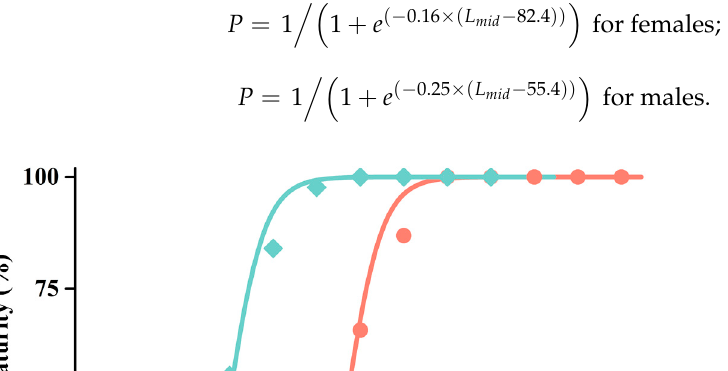
Figure 3. Relationship between body weight ( BW ) and standard length ( SL ) of G. tibetana in the lower Yarlung Tsangpo River.